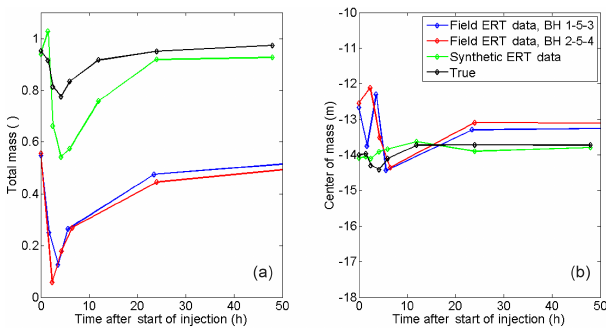
Figure 13. Spatial moments for the field ERT data, synthetic ERT data, and the true data from the flow and transport model. The mo- ments for the true field were calculated in 3-D while those for the ERT tomograms were calculated in 2-D. The field ERT data are separated into the two borehole planes. (a) shows the total mass in the system, normalized, and (b) is the center of mass in the vertical